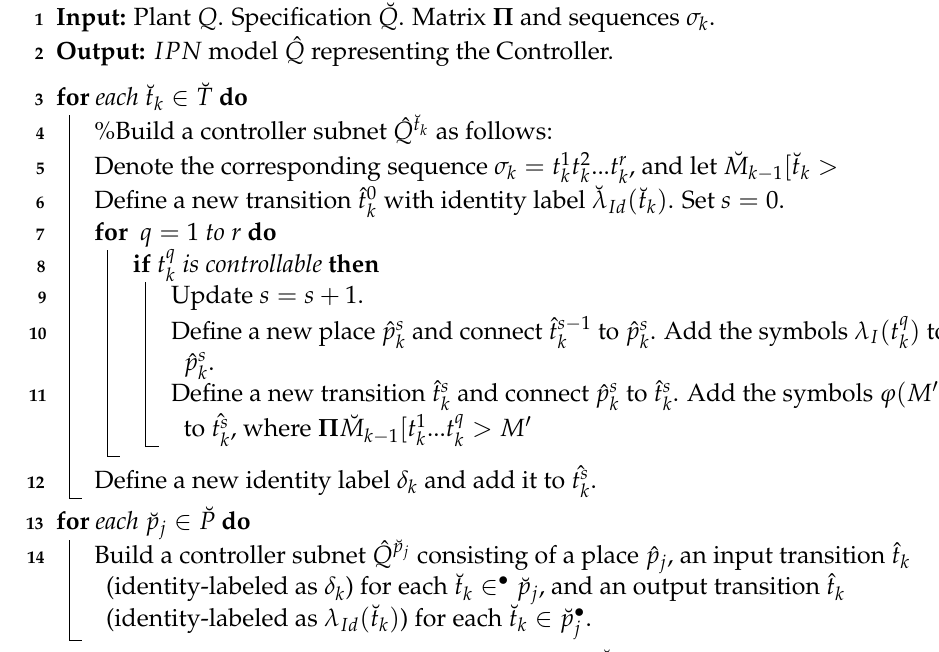
Algorithm 3: Building the IPN